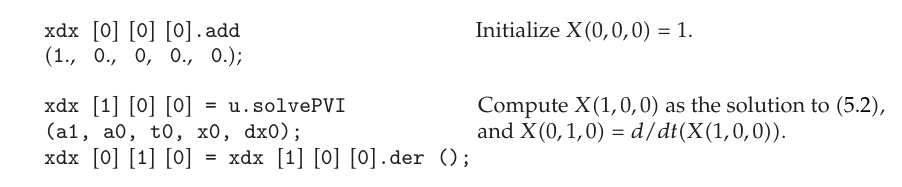
Algorithm 4: Implementation of the algorithm. Steps (cid:3) 3.1 (cid:4) and (cid:3) 3.2 (cid:4)